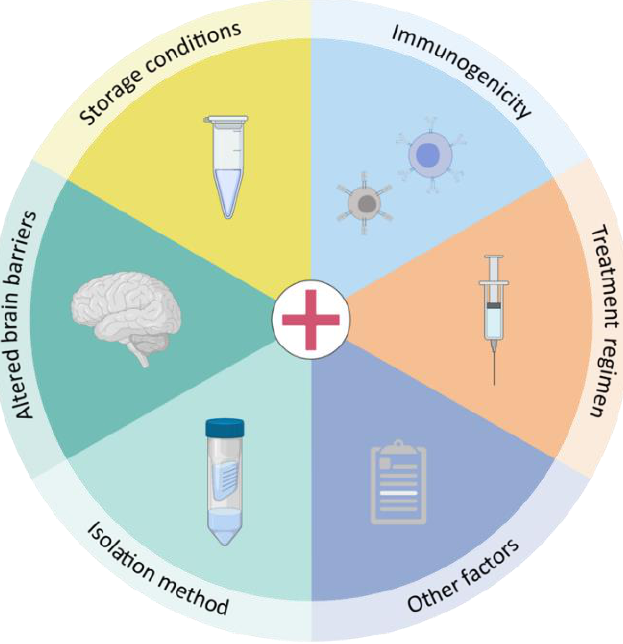
Figure 2. Schematic overview of the discussed practical considerations towards extracellular vesicles (EVs) as a therapeutic delivery platform to the brain. EV protein levels remained constant when stored at −80 °C for up to 28 days, whereas decreasing EV protein levels were observed when preserved at 4 °C or −20 °C [157]. Sim- ilarly, EV storage for 10 days at room temperature or 4 °C caused a clear reduction in protein content whereas this effect was less pronounced after storage at −70 °C [164]. Nonetheless, mass spectrometry (MS) analysis of EVs stored at 4 °C or −80 °C for 4 days revealed profound changes in EV protein content whereby a number of storage-labile pro- teins were lost or leaked into the storage supernatant [163]. Since the latter proteins were